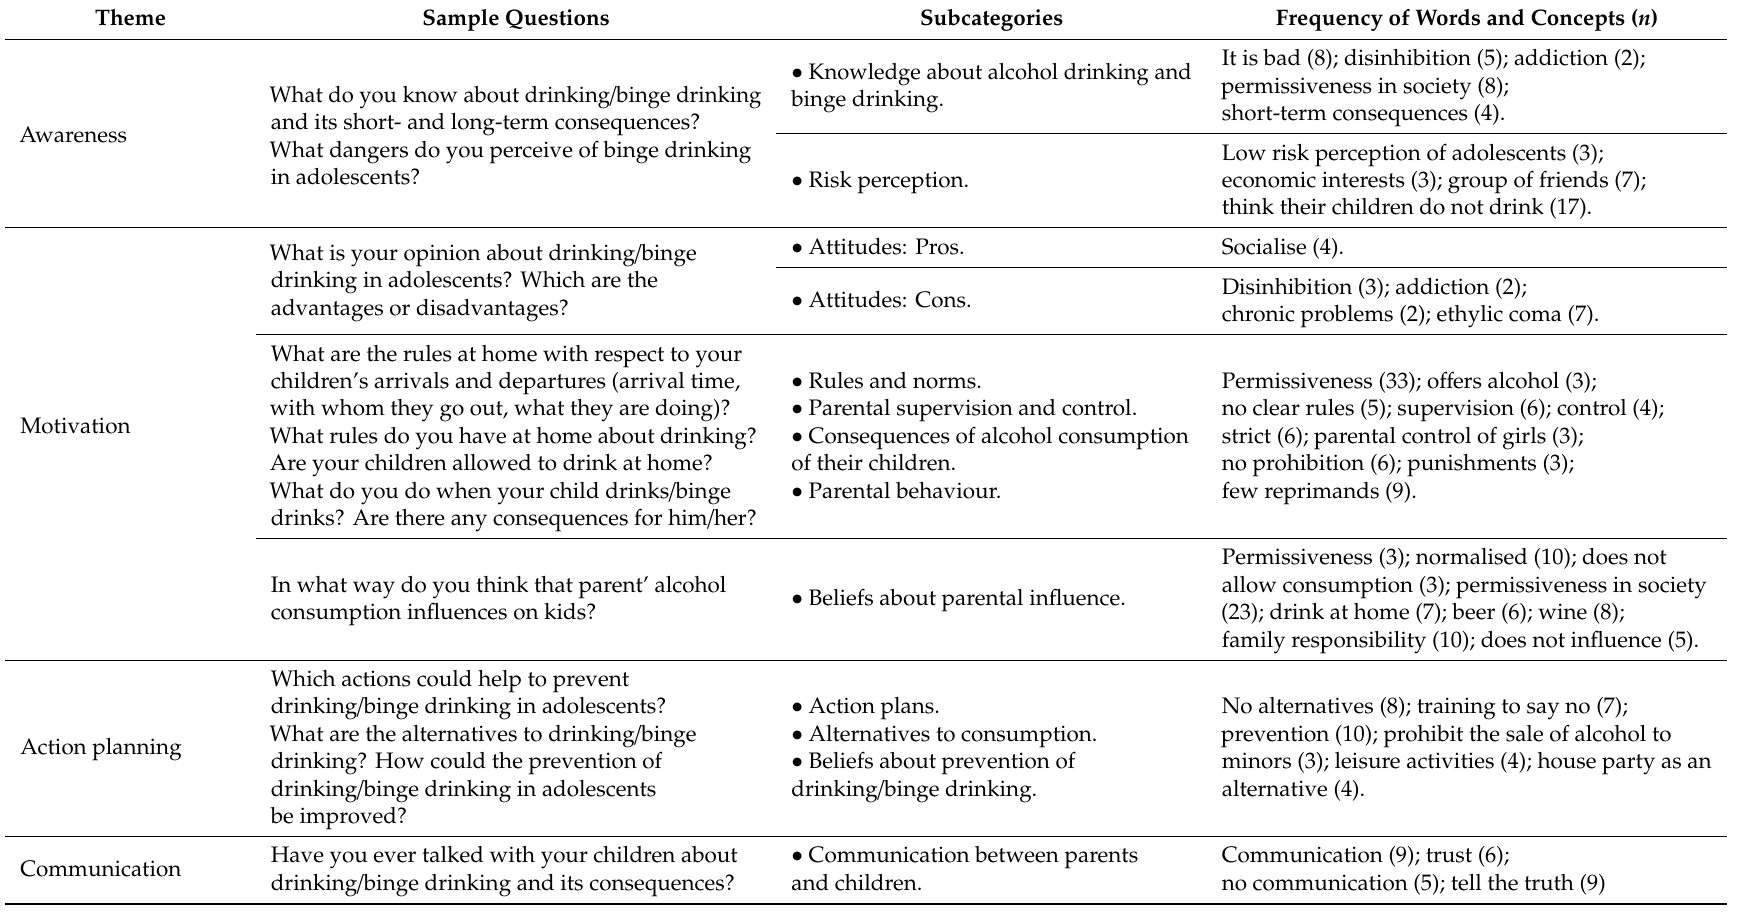
Table 3. Themes, subcategories, frequency of words and concepts, and sample questions for the parent FG